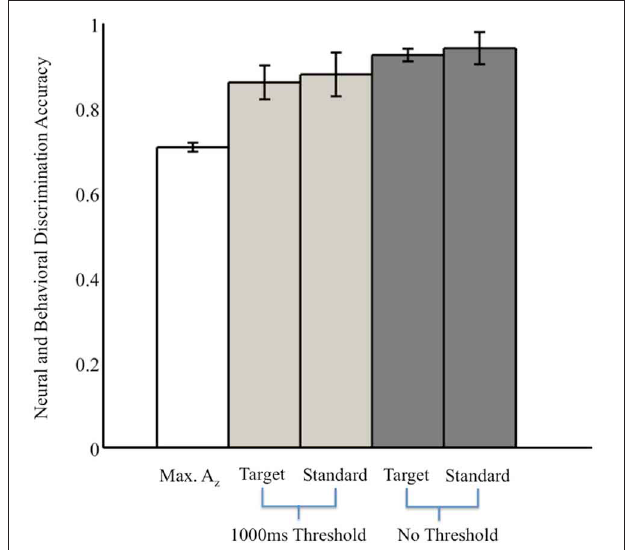
FIGURE 3 | Neural and behavioral discrimination accuracy across all subjects. A z values are reported from stimulus-locked epochs for all subjects with significant discrimination (false-discovery rate corrected, p < 0 . 01). Behavioral accuracy is also shown for all trials across all subjects, as well as response times within the 1000ms threshold used for neural